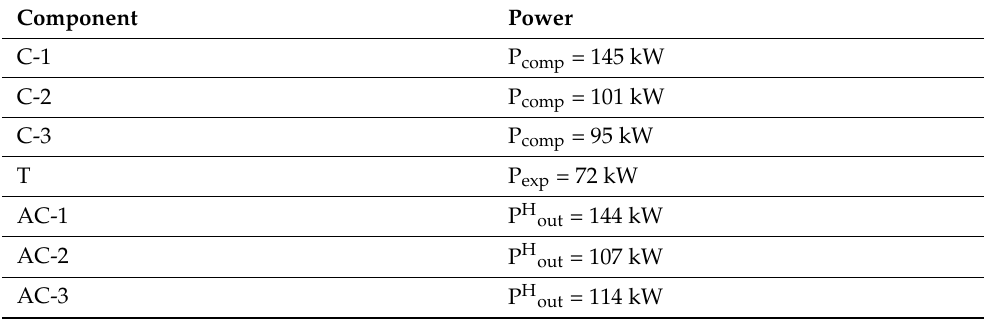
Table A9. This power data refer to operating unit in AC-1.